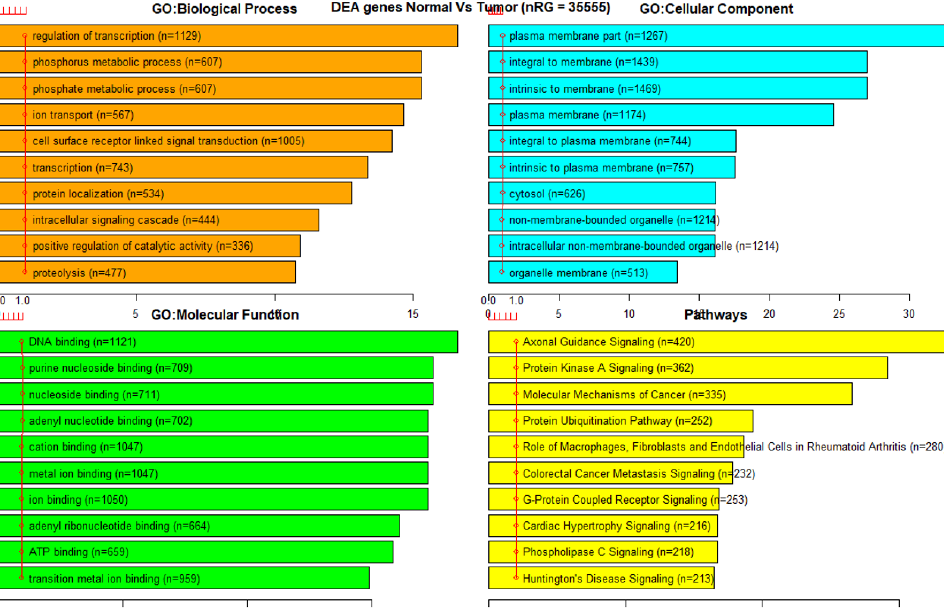
Figure A3. Gene Set Enrichment Analysis on all markers of